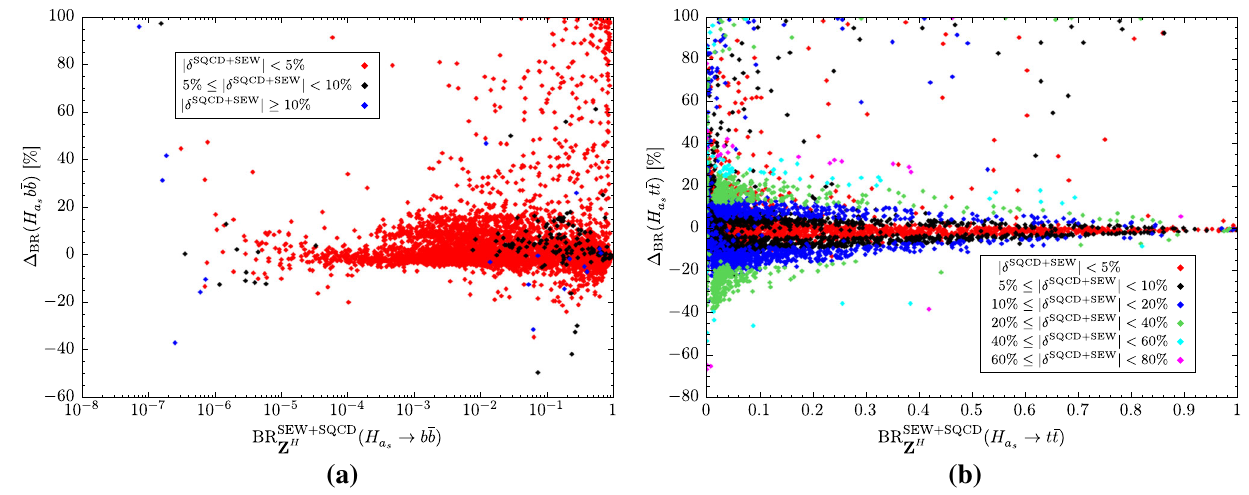
Fig. 4 Scan2: Same as Fig. 2 but for the heavier a s -like Higgs boson H a